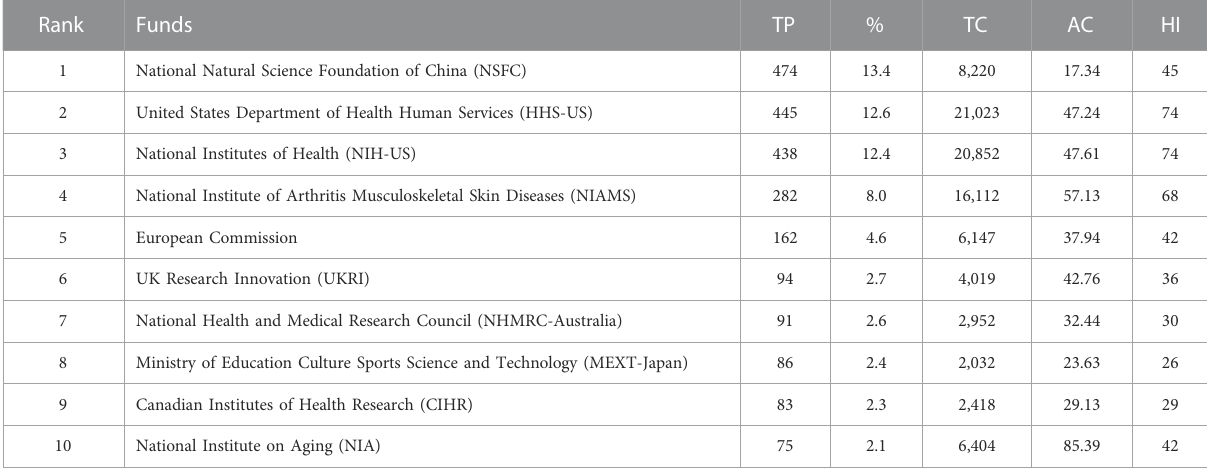
TABLE 4 Top 10 funds with the most publications on subchondral bone research in osteoarthritis.